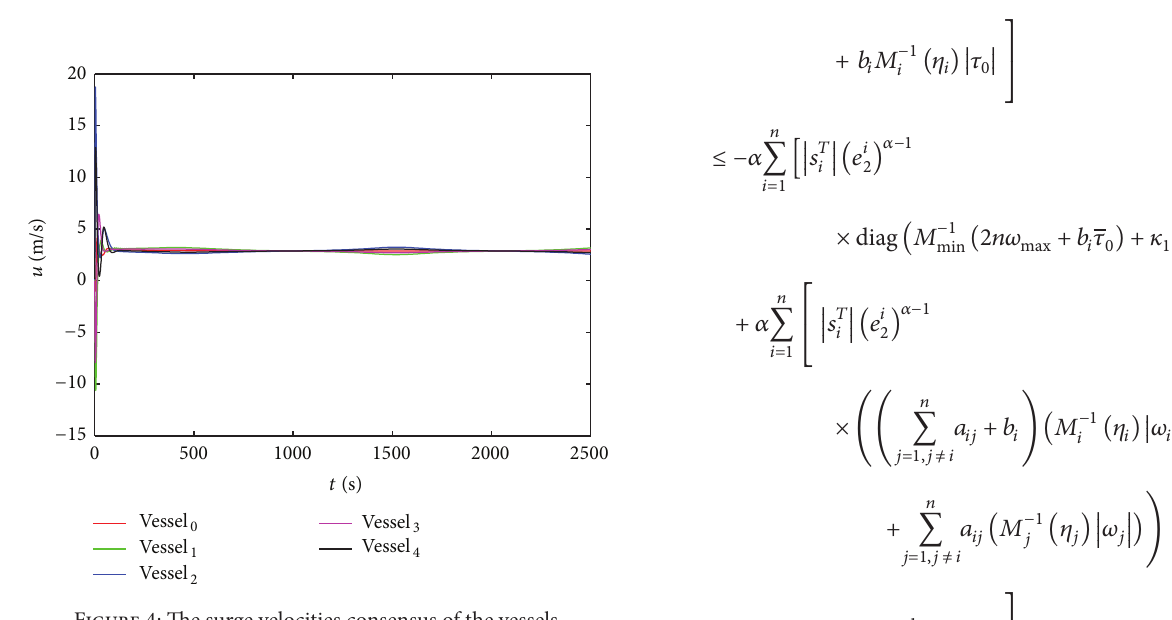
Substituting the control input (30) into (27), then ̇𝑉 = 𝑆 𝑇 × {𝛼 diag (𝐸 𝛼−1 × [((𝐿 + 𝐵) ⊗ 𝐼 − (𝐵 ⊗ 𝐼 − diag { diag (𝑀 −1